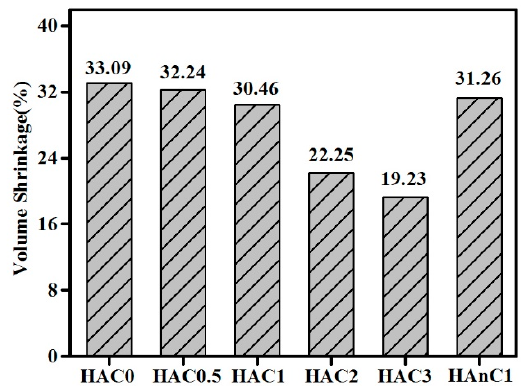
Figure 5. The volume shrinkage of CNTs/HA and nHA–CNTs/HA composites.